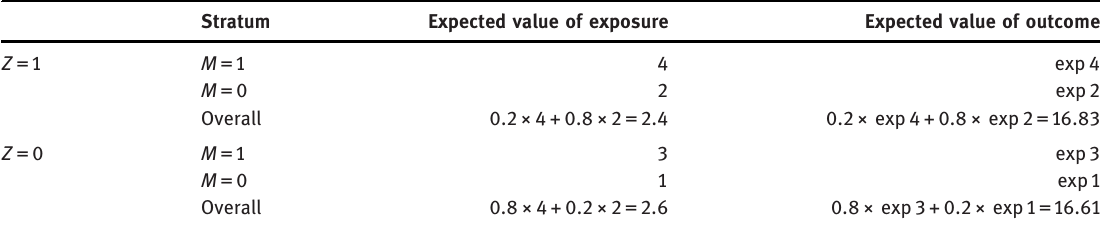
Table 3: Example 3: non-linearity and monotonicity. Instrumental variable estimate is 16.83 − 16.61 effect for all individuals (the outcome is an increasing function of the